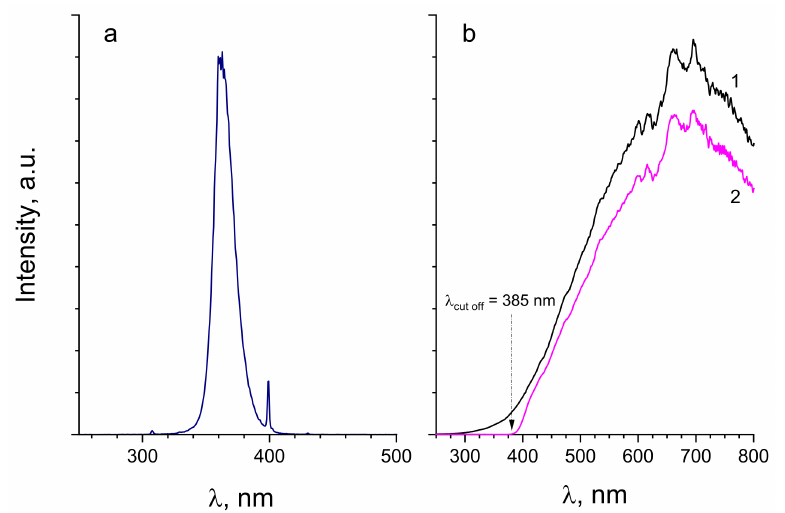
Figure 15. Emission spectra of UVA lamp ( a ) and VIS lamp without (1) and with (2) UV cut-off filter ( b